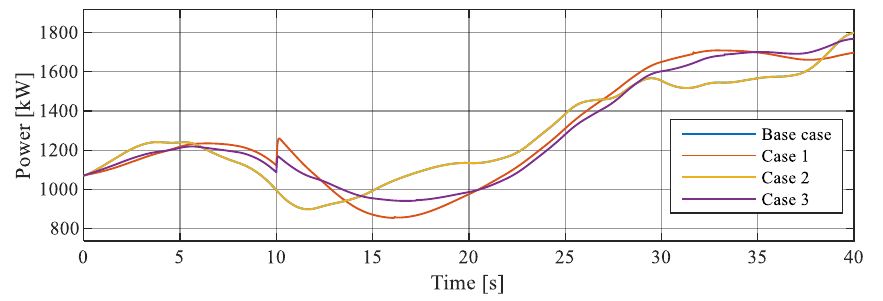
Figure 19. Active power delivered by the three wind turbines under variable wind speed condi- tions.